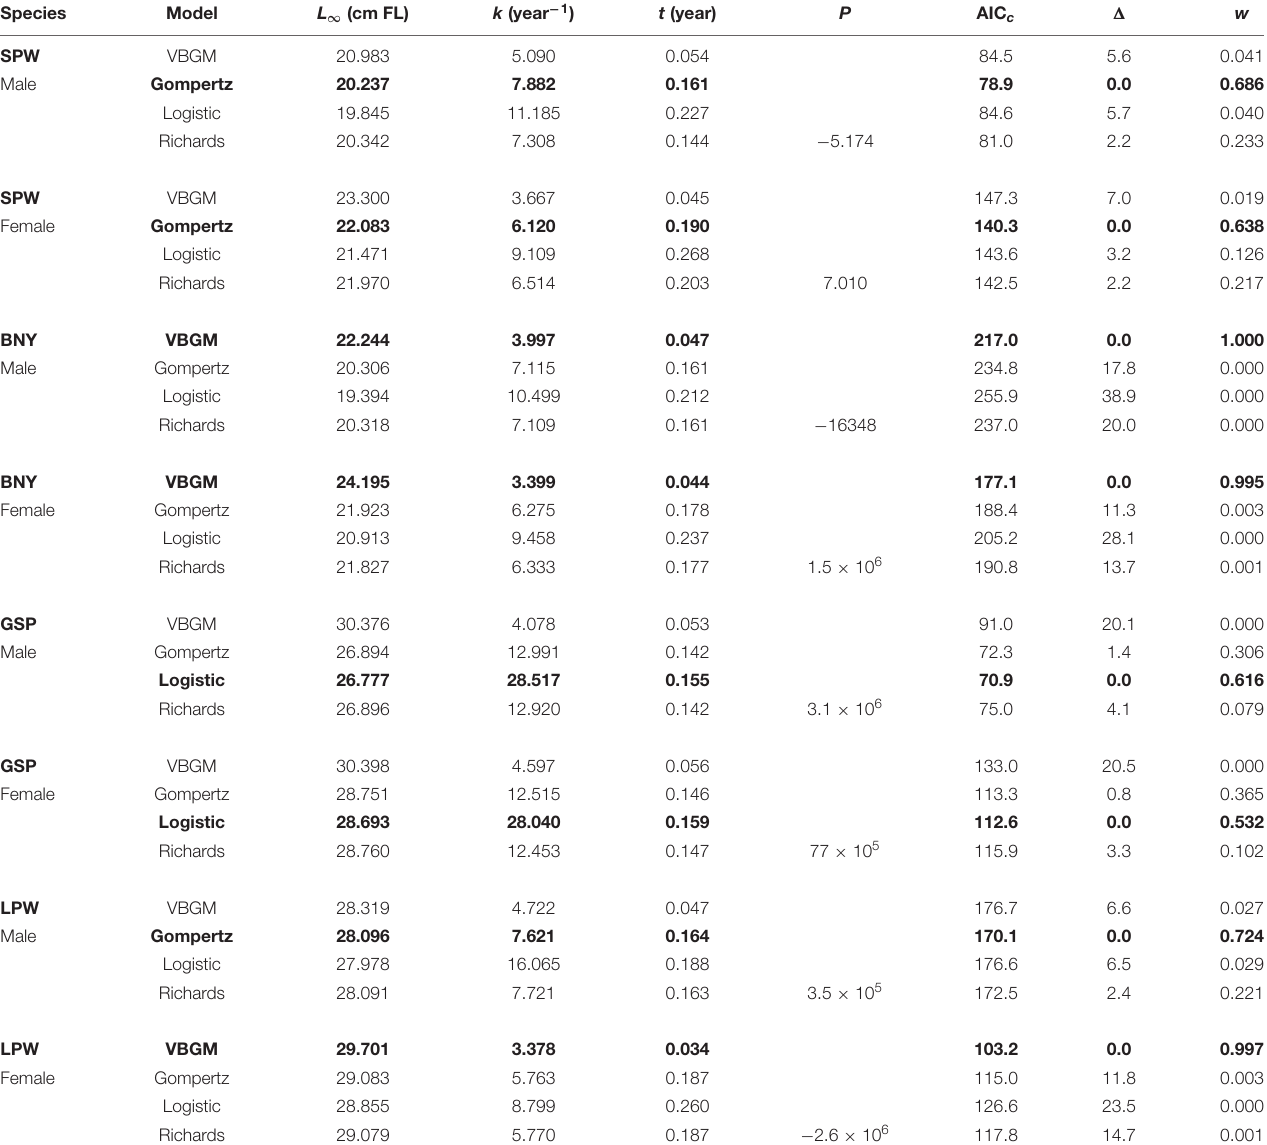
TABLE 4 | Parameter estimates from four candidate growth models, by sex, for the four dominate flyingfishes off Taiwan. Species